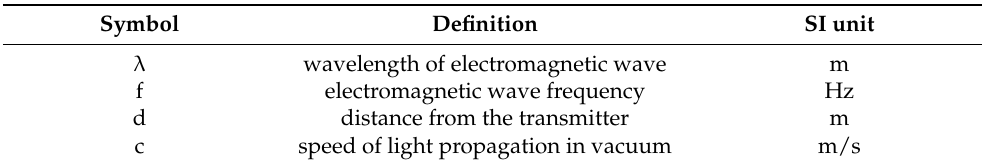
Table 2. Definition of